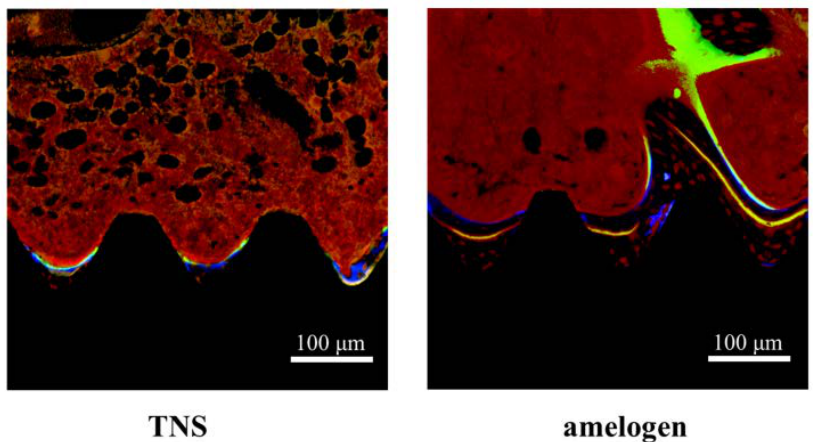
Figure 16. The histological sections were also observed using confocal laser scanning microscopy for dynamic histomorphometry according to fluorescence labeling. (Blue color: 1 week of new bone, yellow color: 4 week of new bone, green color: 8 week of new bone, red color: osteoid).